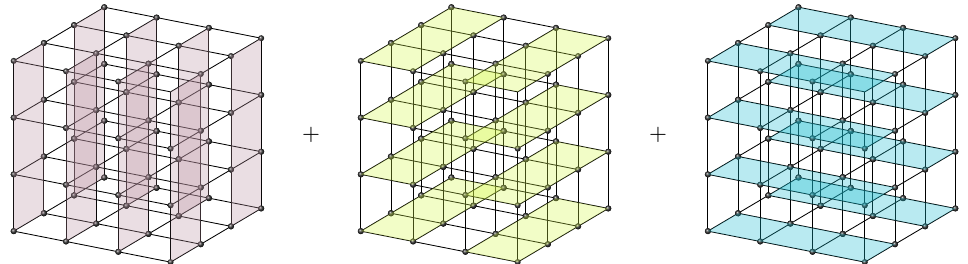
Figure 6 . Particular trivialization of ζ for a three-dimensional torus: ζ is the boundary of the sum of all colored faces. Taking all faces of one color only obtains the sum of all edges in one